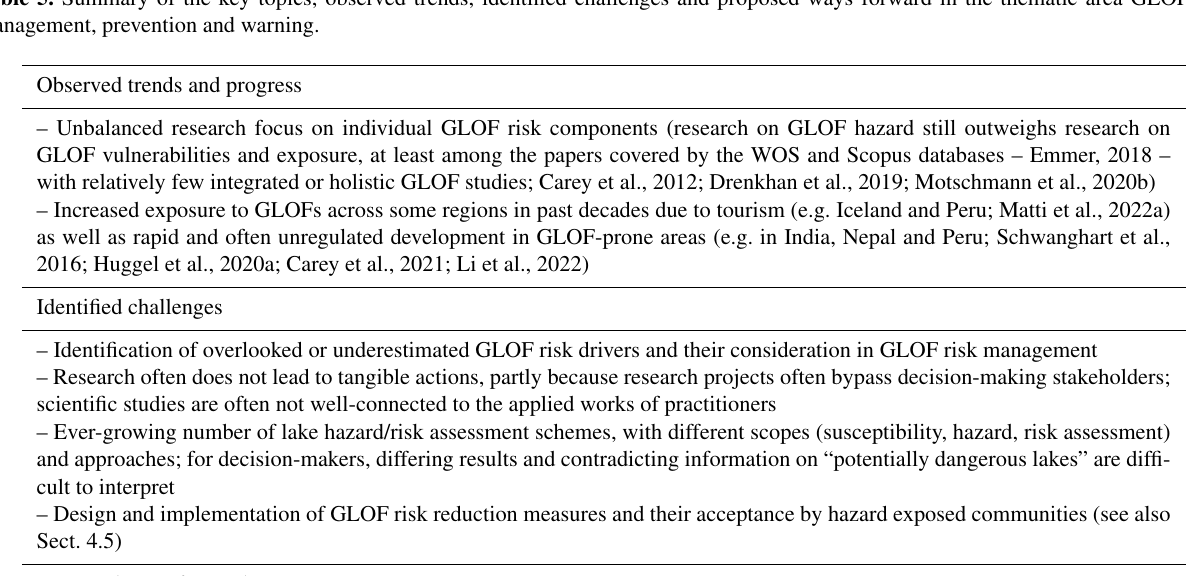
Table 5. Summary of the key topics, observed trends, identified challenges and proposed ways forward in the thematic area GLOF risk management, prevention and